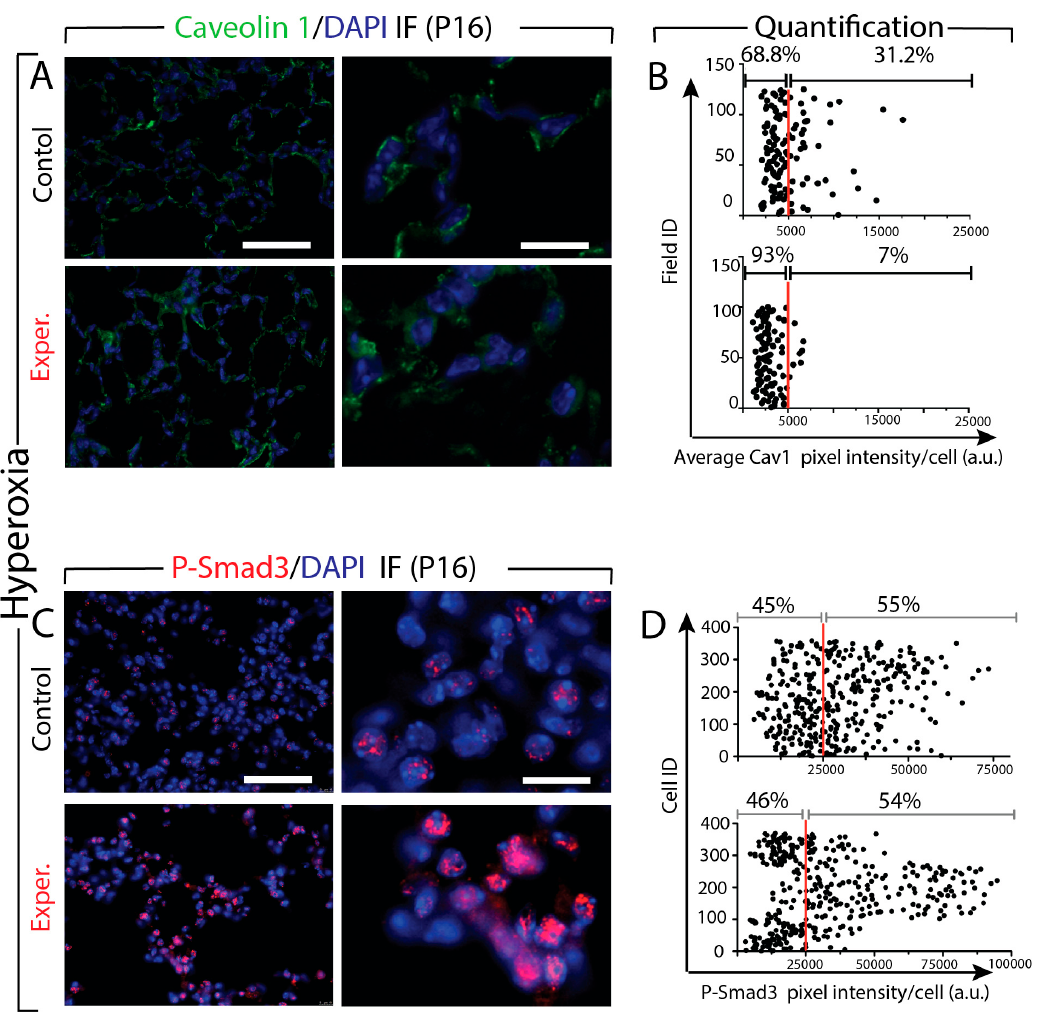
Figure 7. Effect of hyperoxia on the expression of Cav1 and P-Smad3 protein in the lung tissues from control and experimental mice. A . IF images show decrease of Caveolin1 expression. B . Quantification of pixel intensity of Cav1 positive cells indicates a significant decrease of Cav1 expression in the experimental mice. C . The IF images show an increased expression of P-Smad3 in the experimental lungs. D . The quantification of pixel intensity of P-Smad3 positive cells show the same percentile of cells between experimental versus control lungs. Scale bar in A and C: low magnification: 45 μ m; high magnification: 180 μ m.